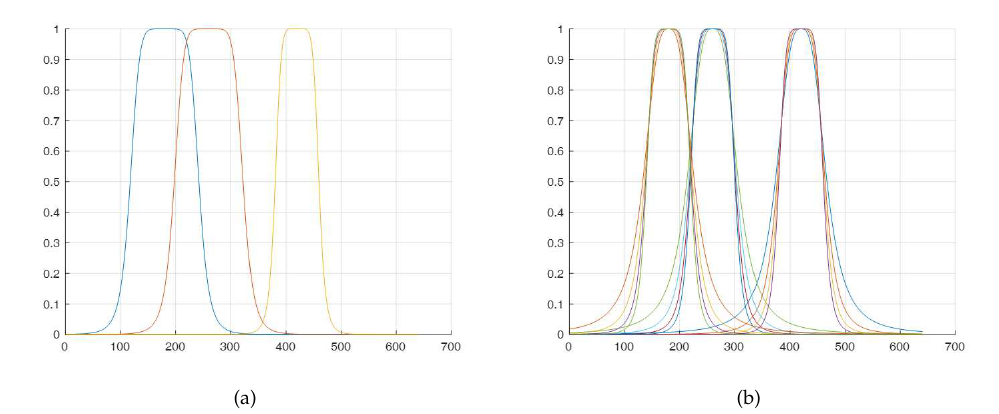
Figure 13. Possible forms of large ( a ) and small ( b ) coincidence of individual AOIs